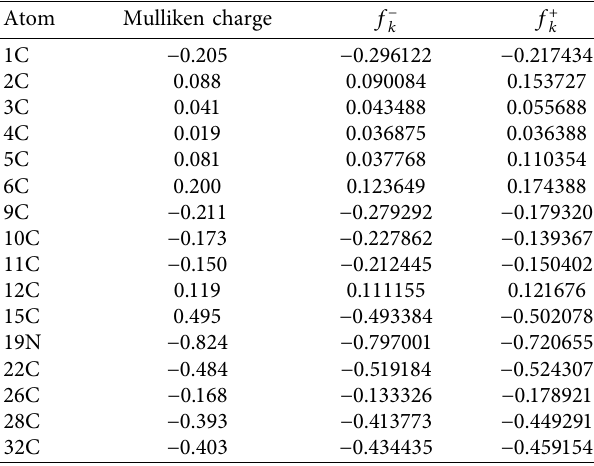
Table 9: Mulliken charges and Fukui indices of ACM.